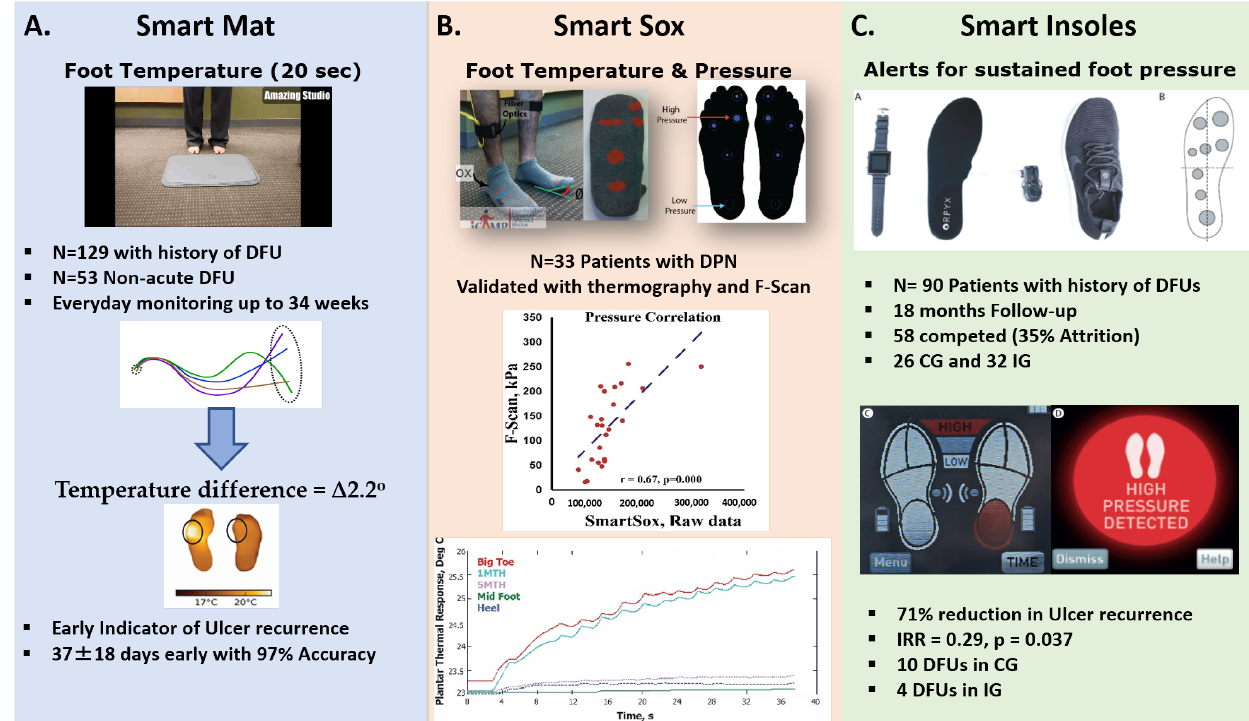
Figure 2. Recently, several digital health technologies are developed to screen digital biomarkers of diabetic foot ulcer (DFU). Three typical examples of these technologies are illustrated in this figure: ( A ) Frykberg et al. (2017) suggested that a smart mat (Podimetrics Mat) enables remote monitoring of plantar temperature and provides a digital biomarker of inflammation which may predict prospective DFU with 37 days lead time and 97% accuracy [16]. The specificity was, however, low (57%), indicating a high false-positive rate. Despite poor specificity, 37 days lead time and high accuracy could make this remote patient monitoring platform a practical device for triaging high-risk patients and timely preventive care. ( B ) Najafi et al. (2017) proposed the concept of SmartSox, which enables continuous screening of the digital biomarkers of DFU, including plantar pressure, temperature, and big toe range of motion [27]. Their results show an acceptable agreement between measured digital biomarkers and gold standards. However, the study is limited to a cross-sectional study, and thus the validity of this technology to predict DFU is unclear. ( C ) Abbott et al. (2019) tested the efficacy of a combination of smart insole and smartwatch that continuously monitor plantar pressure and alert patient via smartwatch when a sustained pressure (pressure lasting longer than 15 min) was detected [28]. In proof of concept randomized control trials, they suggested that such technique may reduce the recurrence of ulcers up to 71%. However, due to the small sample size and high dropout rate, the conclusion of this study is limited. Abbrevietions: (CG) control group, (IG) Intervention group, (DPN) diabetes related pheripheral neuropathy, and (IRR) Incidence rate